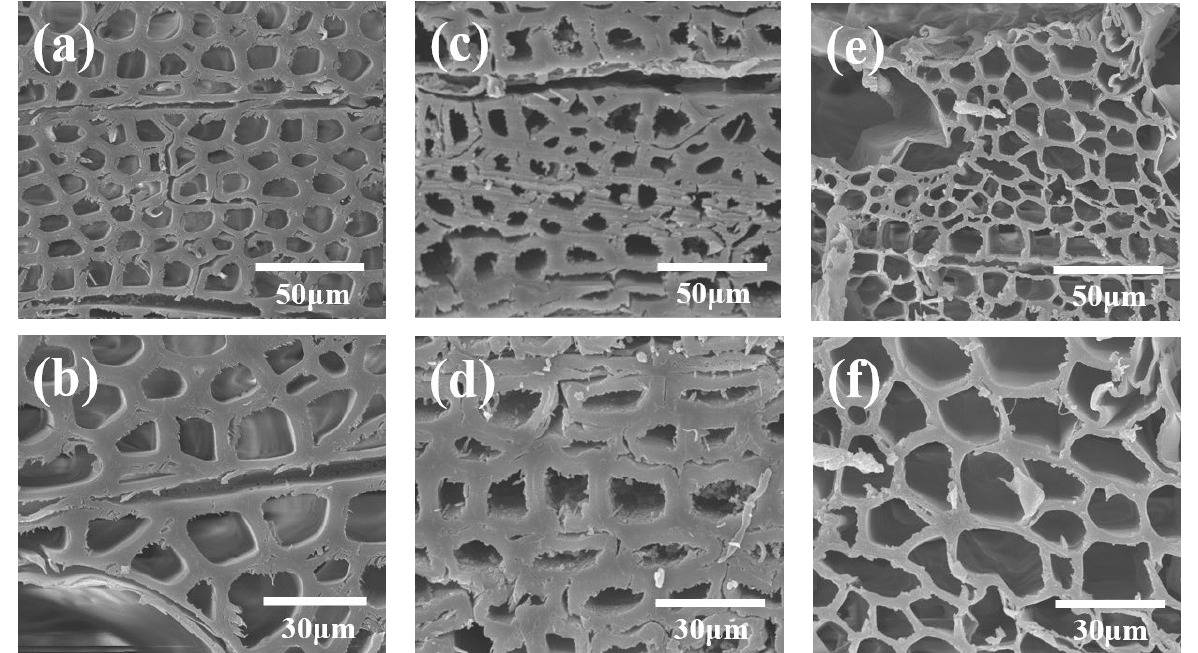
Figure 3. Morphological and structural characterizations of NW and CW. ( a , b ) SEM images of NW. ( c , d ) SEM images of CW-1. ( e , f ) SEM images of CW-2. ( c , d ) SEM images of CW-1. ( e , f ) SEM images of